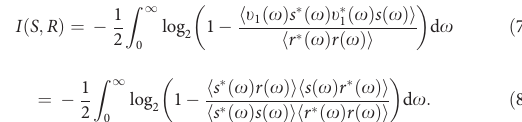
SNR is the stimulus-to-noise ratio, SNR A [0,1), and s ( t ) and n ( t ) are statistically independent processes. The statistics of both s ( t ) and n ( t ) follows either Ornstein– Uhlenbeck Gaussian process 50 (Figs 3–6 and Supplementary Figs 1–3)